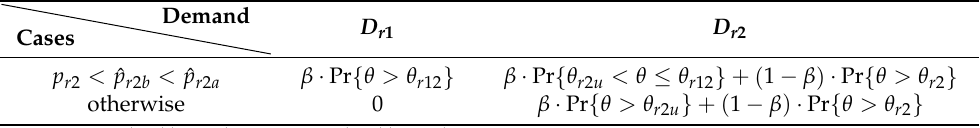
Table 3. Demand for remanufactured products in different